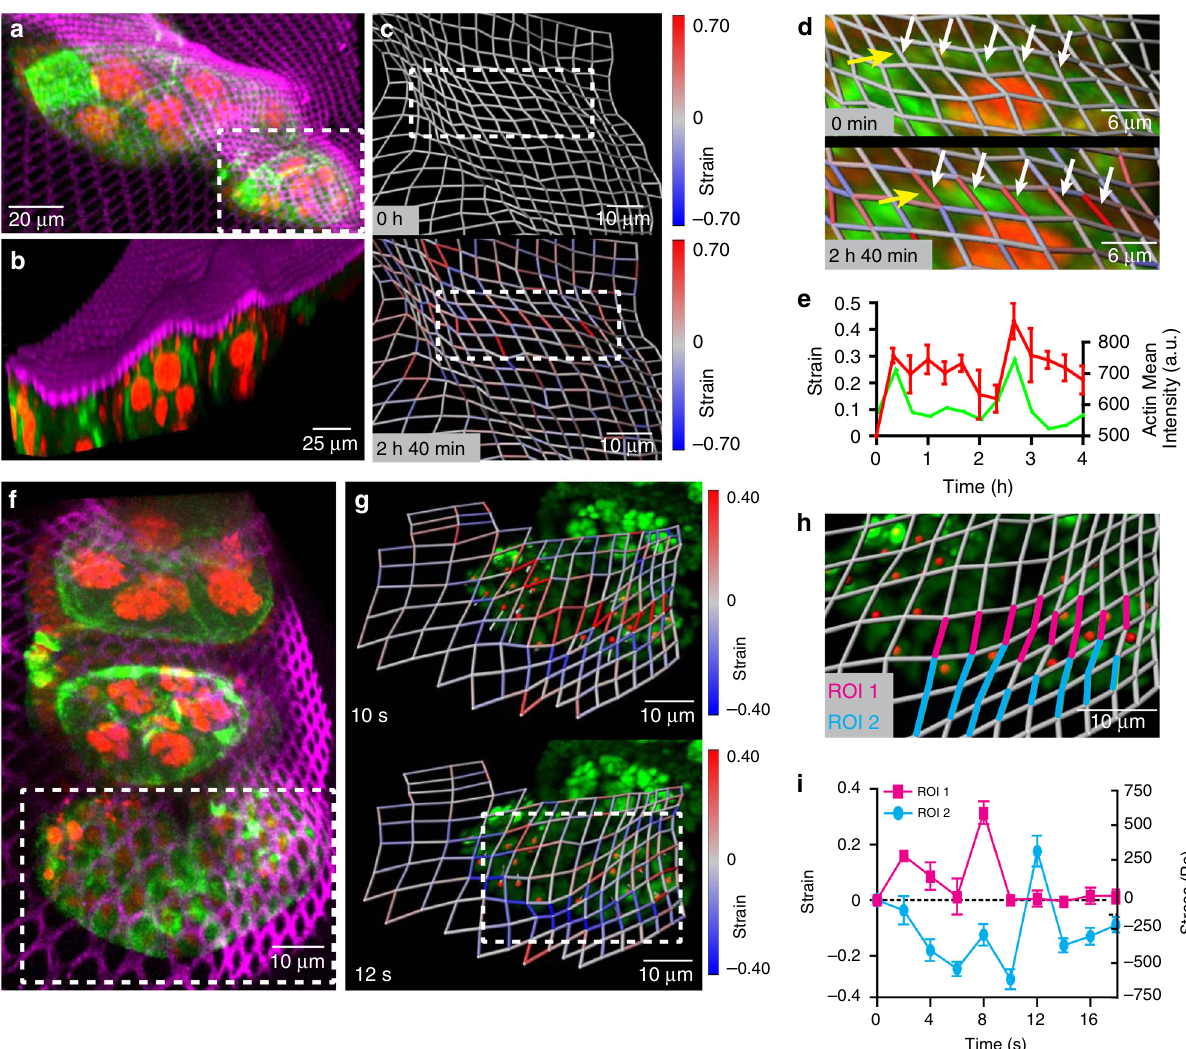
Fig. 5 Utilizing the NMBS for 3D strain mapping on Drosophila ovariole tissue. a Maximum intensity projection of fl uorescence image from live 3D confocal imaging of Alexa-647 fi bronectin NMBS (Magenta, 2 µ m × 2 µ m × 2 µ m) applied to a developing Drosophila ovariole expressing moesin-GFP (Green) and Histone-2B-RFP (Red). b 3D render of a diagonal cut plane demonstrating the ability of the NMBS to conform to the 3D surface of the ovariole. c Strain analysis and quanti fi cation of region in a (white box) at two time points show regionally localized tensile (red) and compressive (blue) strain over time. d Magni fi ed images (white box in c ) of high tensile region (white arrows) corresponding to localized moesin-GFP fl uorescence (green, yellow arrows). e Quanti fi cation of the average tensile strain (red, white arrows) within the magni fi ed region shows strain peaks correlate with increased moesin- GFP fl uorescence (green, yellow arrows) over a 4-h time course (mean S.D.; n = 5 segments over 1 experiment). f Maximum intensity projection of fl uorescence image from live high-speed spinning-disk confocal imaging of Alexa-647 fi bronectin NMBS (Magenta, 2 µ m × 2 µ m × 2 µ m) applied to a contracting Drosophila ovariole expressing moesin-GFP (green) and Histone-2B-RFP (red). g Time-lapse imaging of region in f (white box) at 0.5 Hz of a 20 µ m section of a contracting ovariole with the NMBS (magenta) and histone-2B-RFP (green). Regions of tension ( t = 10 s, max of 1.55) and compression ( t = 12 s, max of 0.63) are observed during contraction and extension respectively. As the nuclei translate upward during ovariole contraction ( t = 10 s; red dots, gray commit tails) there is an increase in tension at their leading edge (max tension = 1.44). As the nuclei move down and the ovariole compresses ( t = 12 s), a band of compression along the bottom edge of the ovariole is observed (max compression = 0.60). h Magni fi ed image of strain analysis showing the 3D deformation during ovariole contractions and highlighting regions of compression and tension for quanti fi cation. i Quanti fi cation of the maximum tensile and compressive regions within the strain map, (ROI 1, magenta; ROI 2, cyan) of the contracting ovariole. Stress during contraction was calculated by using values for the elastic modulus of the germarium and stage 1 ovariole of 2 kPa (mean ± S.D.; ROI 1 n = 10 segments and ROI 2 n = 14 segments over 1